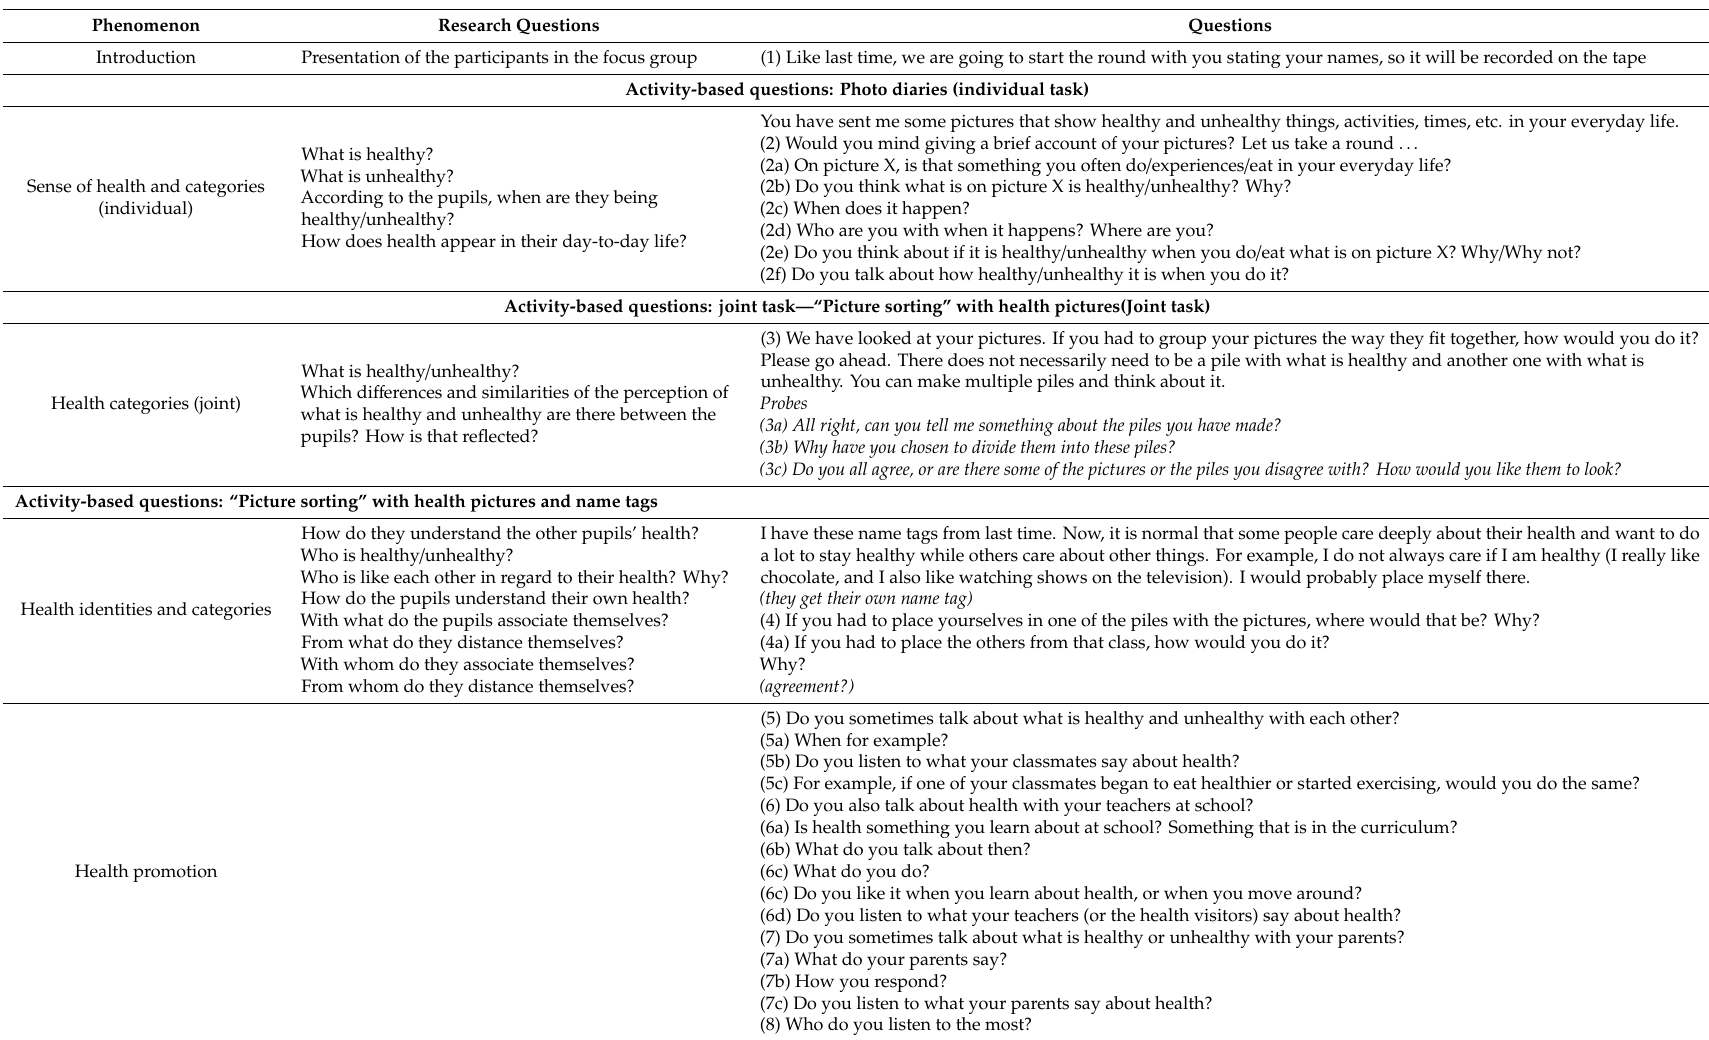
Table A2. Interview guide 2: Health categories and identities in the